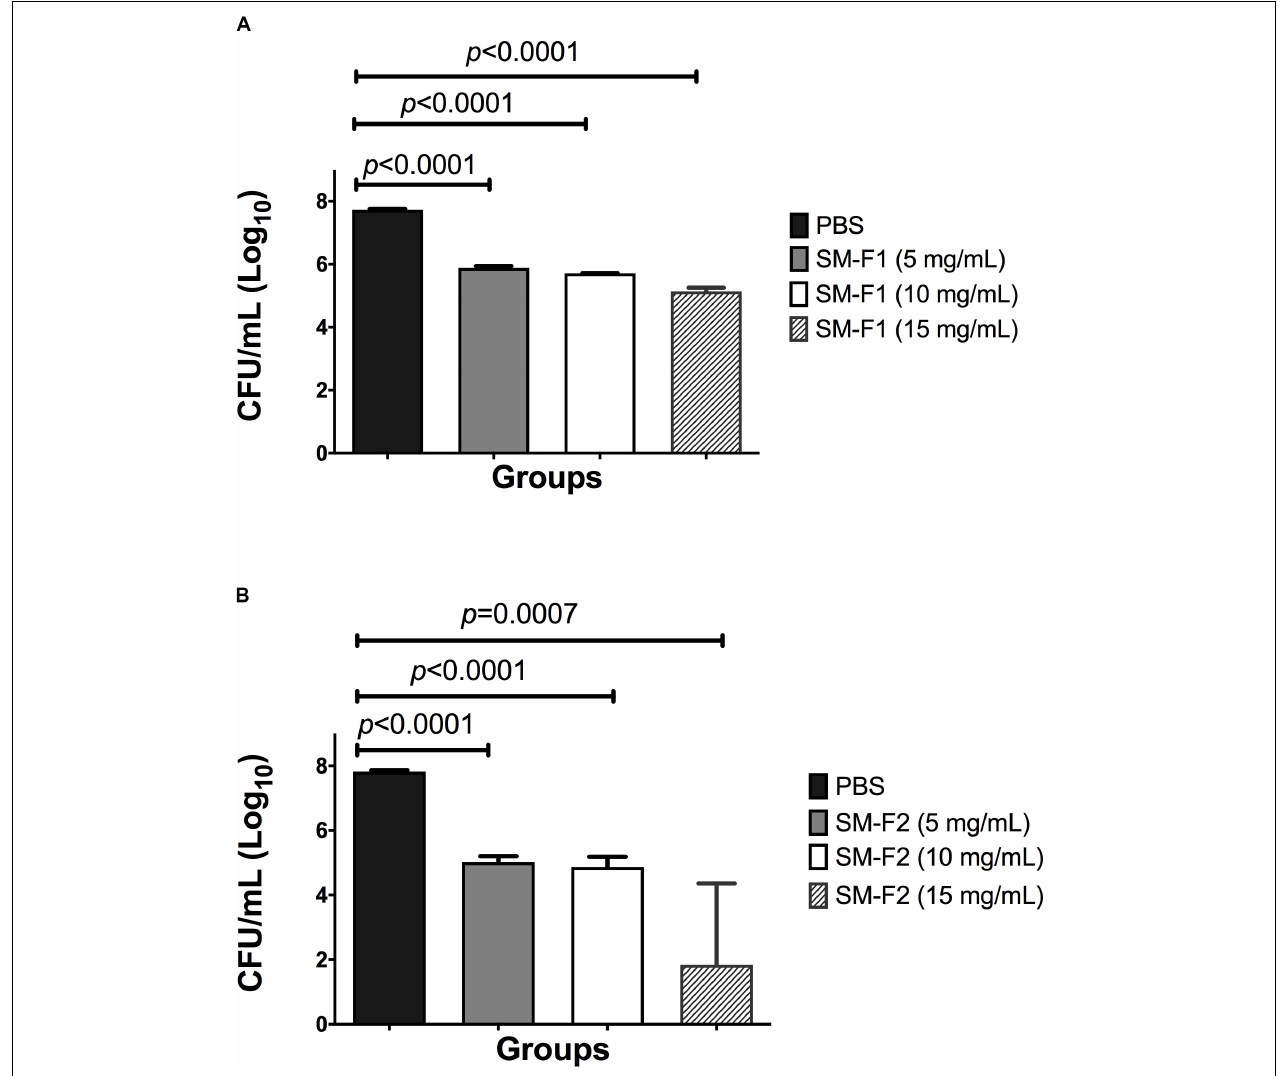
FIGURE 1 | Analysis of in vitro Candida biofilms. Mean and SD of CFU/mL (Log 10 ) of C. albicans viable cells obtained for the non-treated control group (PBS) and the experimental groups treated with the SM-F1 (A) or SM-F2 (B) fractions at 5, 10, and 15 mg/mL. Student’s t -test was used to compare the control group with the experimental